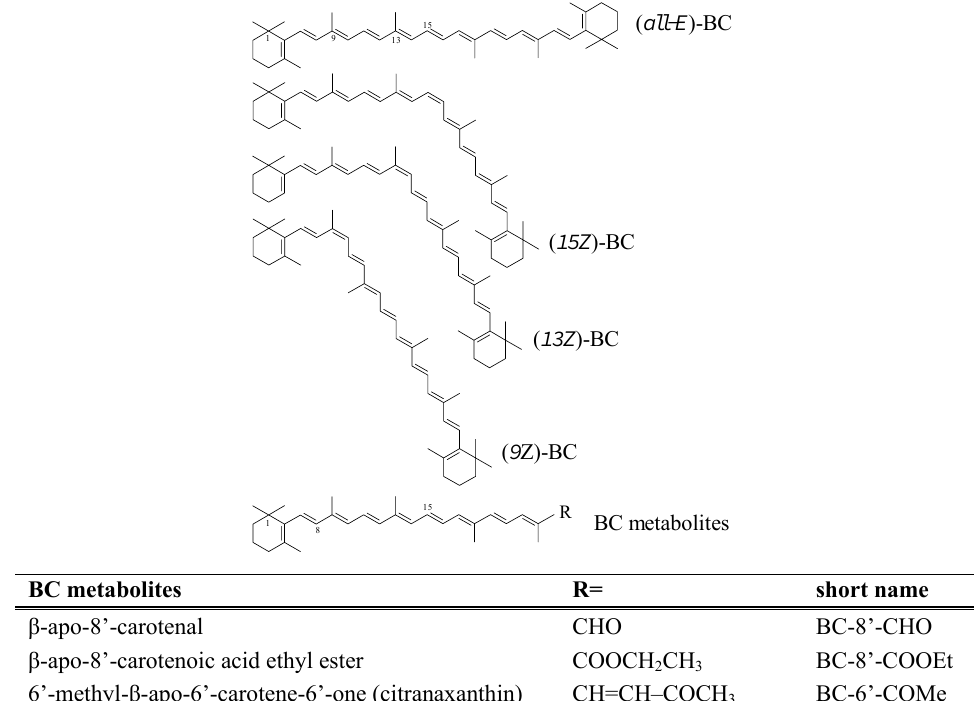
Figure 1. Structures of analyzed β -carotene (BC) isomers and